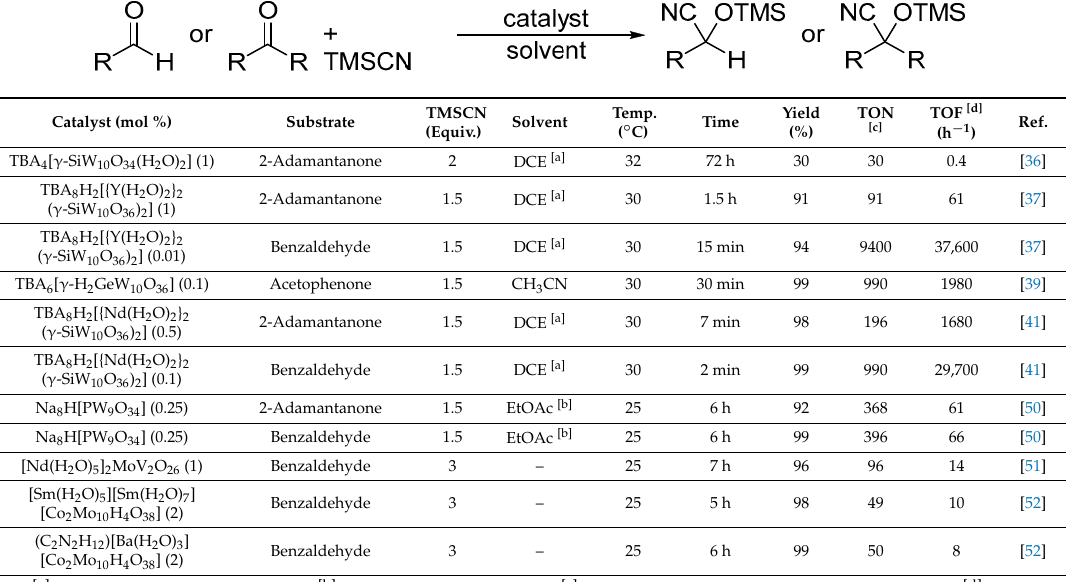
Table 3. Cyanosilylation of carbonyl compounds with trimethylsilyl cyanide (TMSCN) by POM base catalysts.